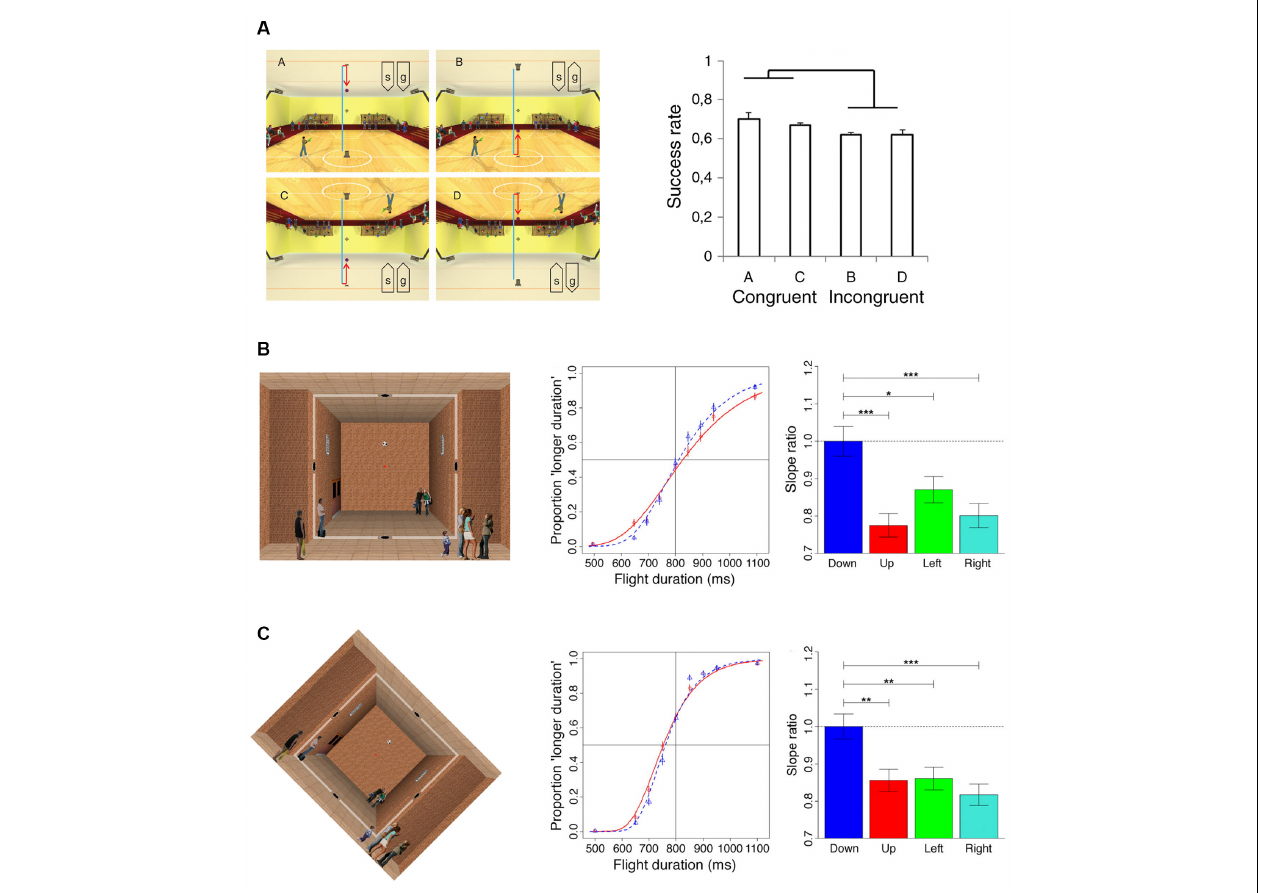
FIGURE 1 | Results of psychophysical experiments manipulating the direction of the “visual” gravity vector relative to physical gravity. (A) The four panels on the left side illustrate the scenarios (indicated with “a”, “b”, “c”, “d”) employed in Experiment 1 of Zago et al. (2011a). A ball was launched vertically and bounced back hitting the opposite side. The ball decelerated until bouncing (blue trajectory), and then it accelerated (red trajectory). Participants pressed a button to trigger the standing character to shoot a bullet to hit the ball at the interception point (indicated by the crosshair). The orientation of the scene (“s”) and the direction of the simulated gravity acting on the target (“g”) were manipulated in different blocks of trials: (upper left, scenario “a”) normal scene orientation and gravity, (upper right, scenario “b”) normal scene orientation but inverted target gravity, (lower left, scenario “c”) both scene and gravity were inverted, and (lower right, scenario “d”) inverted scene and normal target gravity. The panel on the right side illustrates the interception scores (success rates) observed for the four scenario conditions described above. (B) The leftmost panel illustrates the background scene and the visual target of Experiment 1 of Moscatelli and Lacquaniti (2011). The soccer ball moved at constant acceleration between two holes located on opposite sides of the room and, in different blocks of trials, along four possible directions: downward, upward, rightward, or leftward. Ball kinematics was congruent with the effects of gravity only in the downward direction. Participants maintained fixation throughout the trial on the red dot at the center of the scene. The middle panel illustrates the psychometric functions for downward (blue) and upward motion (red), obtained by pooling data of the seven participants of Experiment 1. The rightmost panel shows the precision of discrimination for the four directions of motion quantified by the slope of a Generalized linear mixed model fitted to the subject population data. Slopes were normalized to the values obtained for the downward direction. Error bars refer to ± 1 SD; ***, ** and * denote significant differences at p < 0.001, p < 0.01 and p < 0.05 level, respectively. (C) The leftmost panel illustrates the visual scene used for Experiment 6 of Moscatelli and Lacquaniti (2011), which was identical to Experiment 1, except for the 45 degrees clockwise rotation of the computer display. The middle and rightmost panels illustrate the results of this experiment with the same format as the corresponding panels in (B)